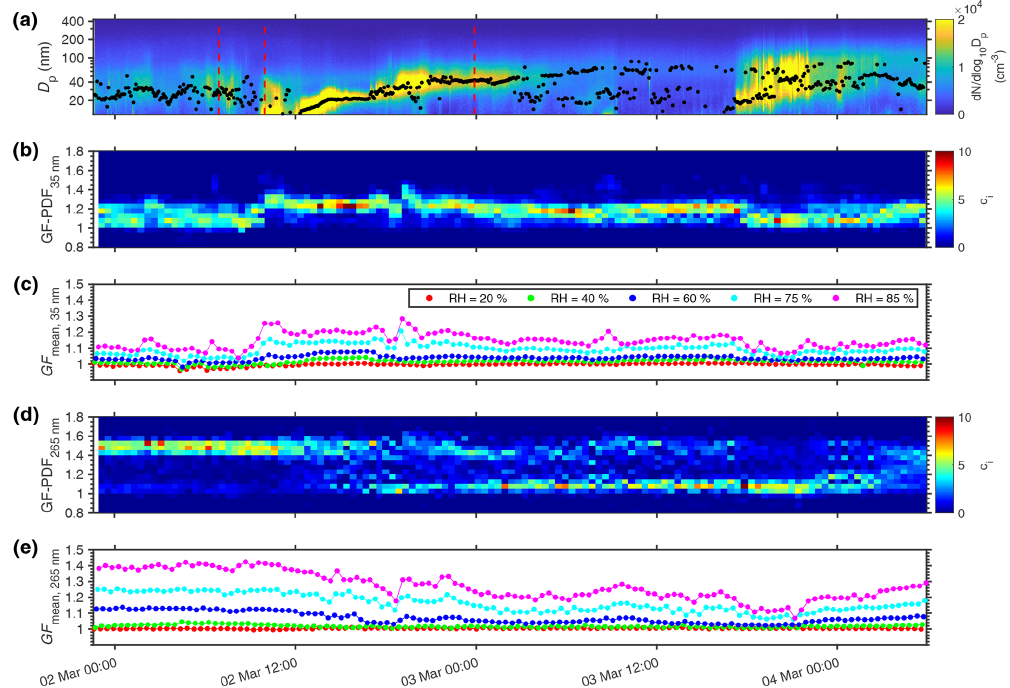
Figure 5. Aerosol size distribution measured by SMPS and GF-PDF retrieved from HFIMS measurements on the Danforth campus of Washington University in St. Louis from 1–4 March 2021. (a) Temporal evolution of aerosol size distributions ranging from 11.7 to 429.4nm. Black dots are the fitted geometric mean diameter of the mode with the highest number concentration. (b, d) Temporal evolution of probability density function of growth factor of 35 and 265nm particles at 85% RH. (c, e) Time series of mean growth factor of 35 and 265nm particles at five RH levels (20%, 40%, 60%, 75%, and